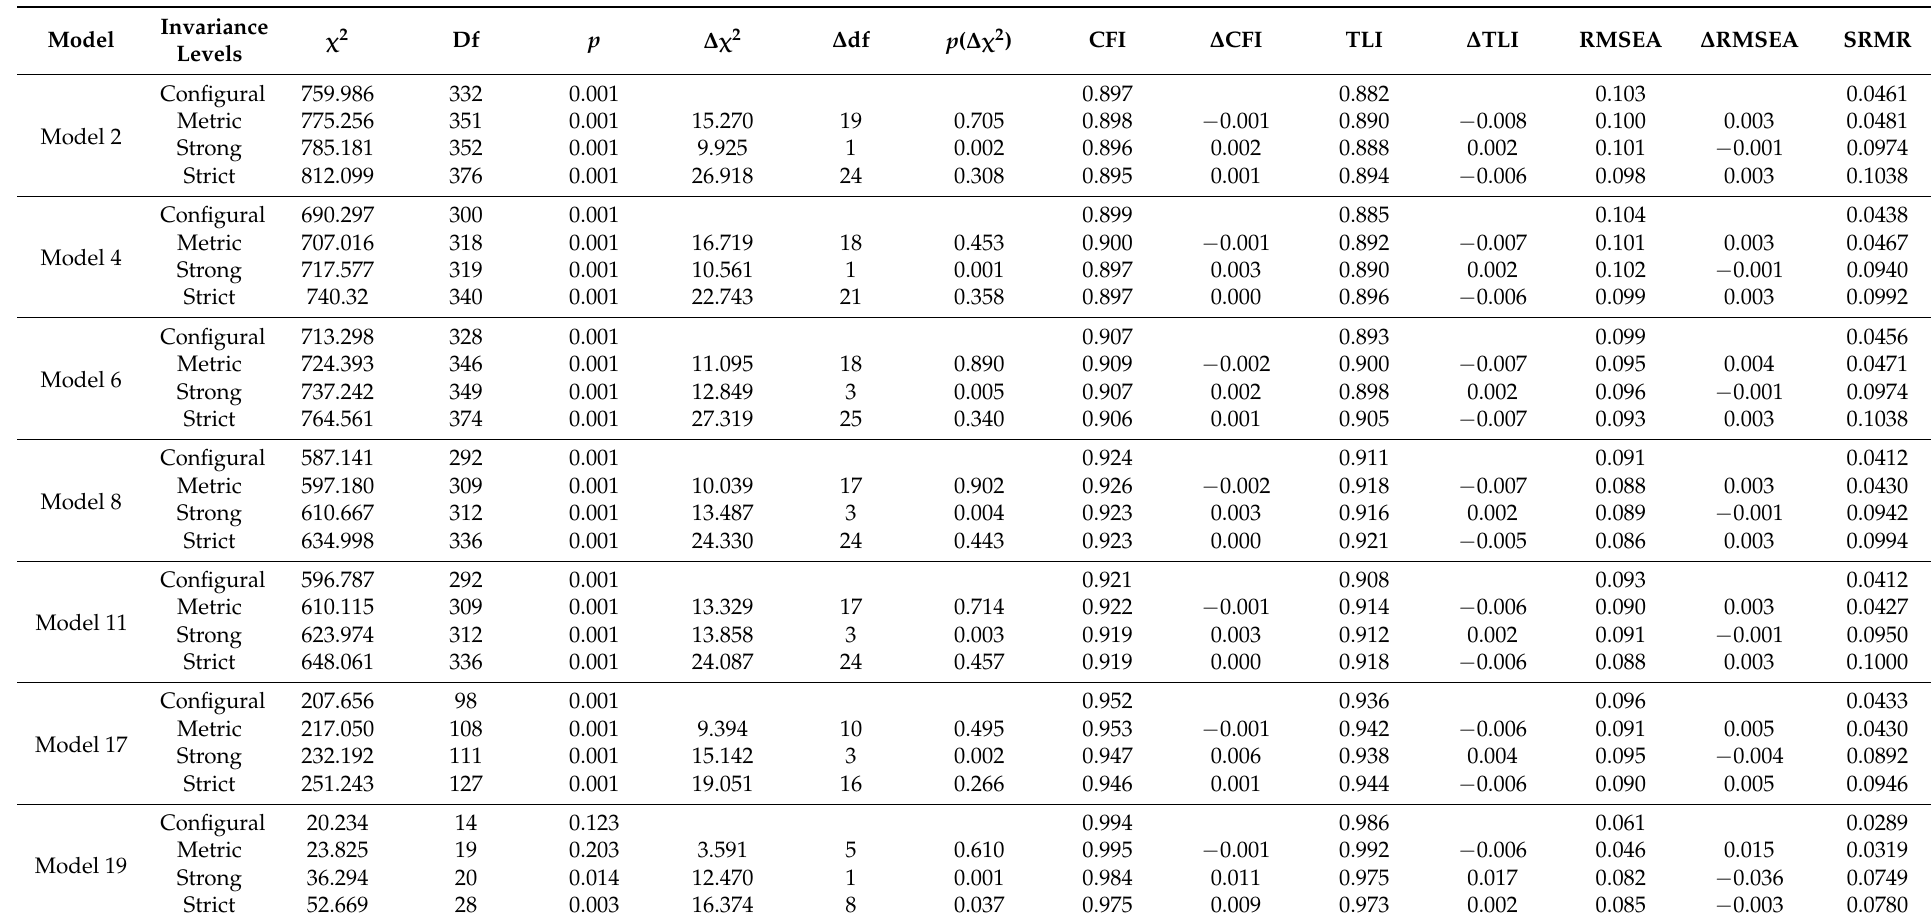
Table 4. Invariance of factor structures of the Internet Addiction Test across groups of eating